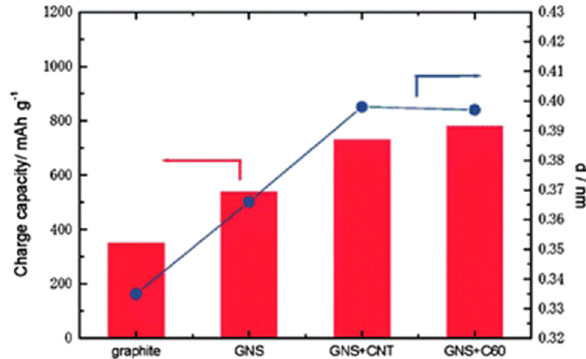
Figure 39: Graphene nanosheet d - spacing and charge capacity relationship. Adapted with permission from ref. [ 420 ] ; Royal Society of Chemistry,